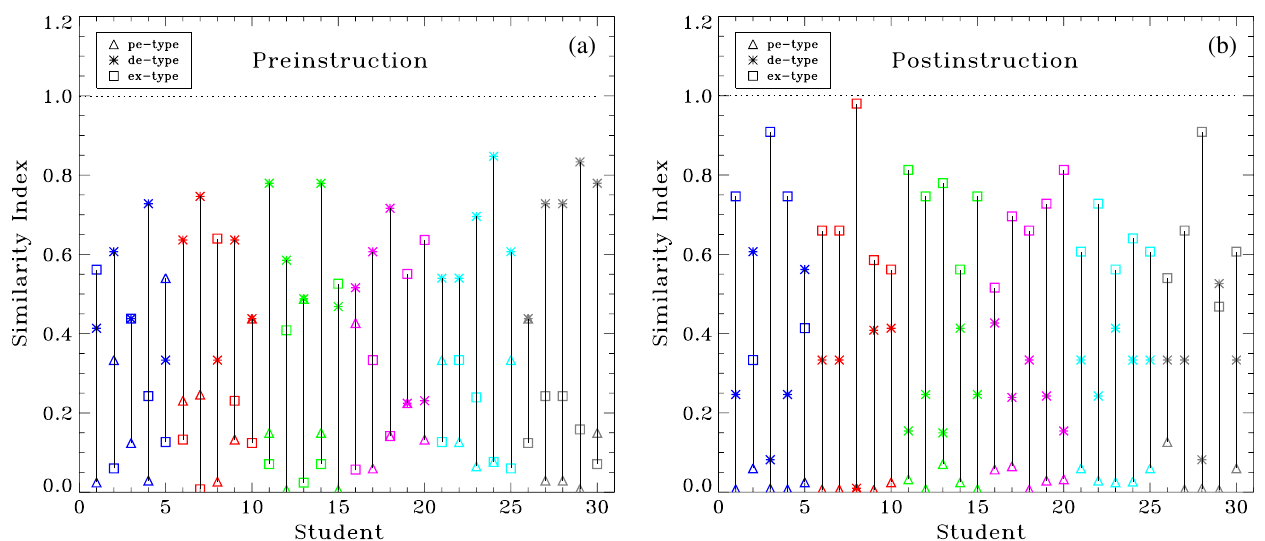
FIG. 3 (color online). Similarity index for each student answering the questionnaire before (left panel) and after (right panel) the carrying out of the OI-based instruction, in relation to the pe-type, de-type, and ex-type characteristic profiles. An integer index on the abscissa is associated to each student and used to identify the learner. As in Fig. 2, colors are used to identify students who worked within the same group.